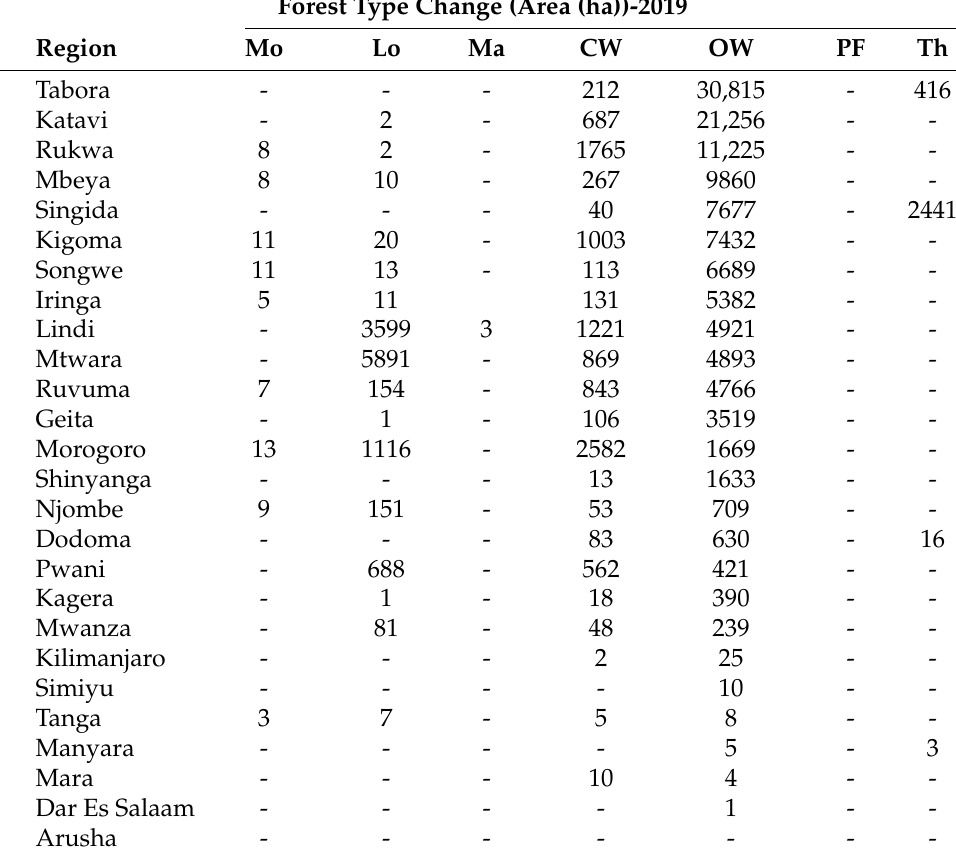
Table 14. Forest type change by regions.